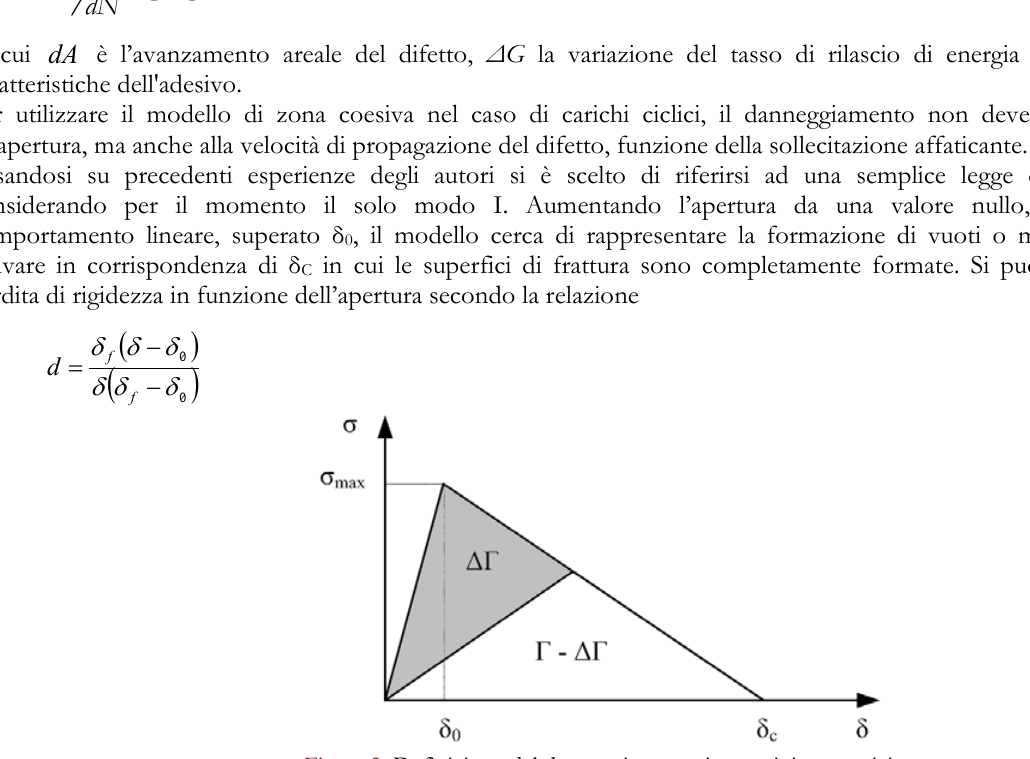
Figura 3: Definizione del danneggiamento in termini